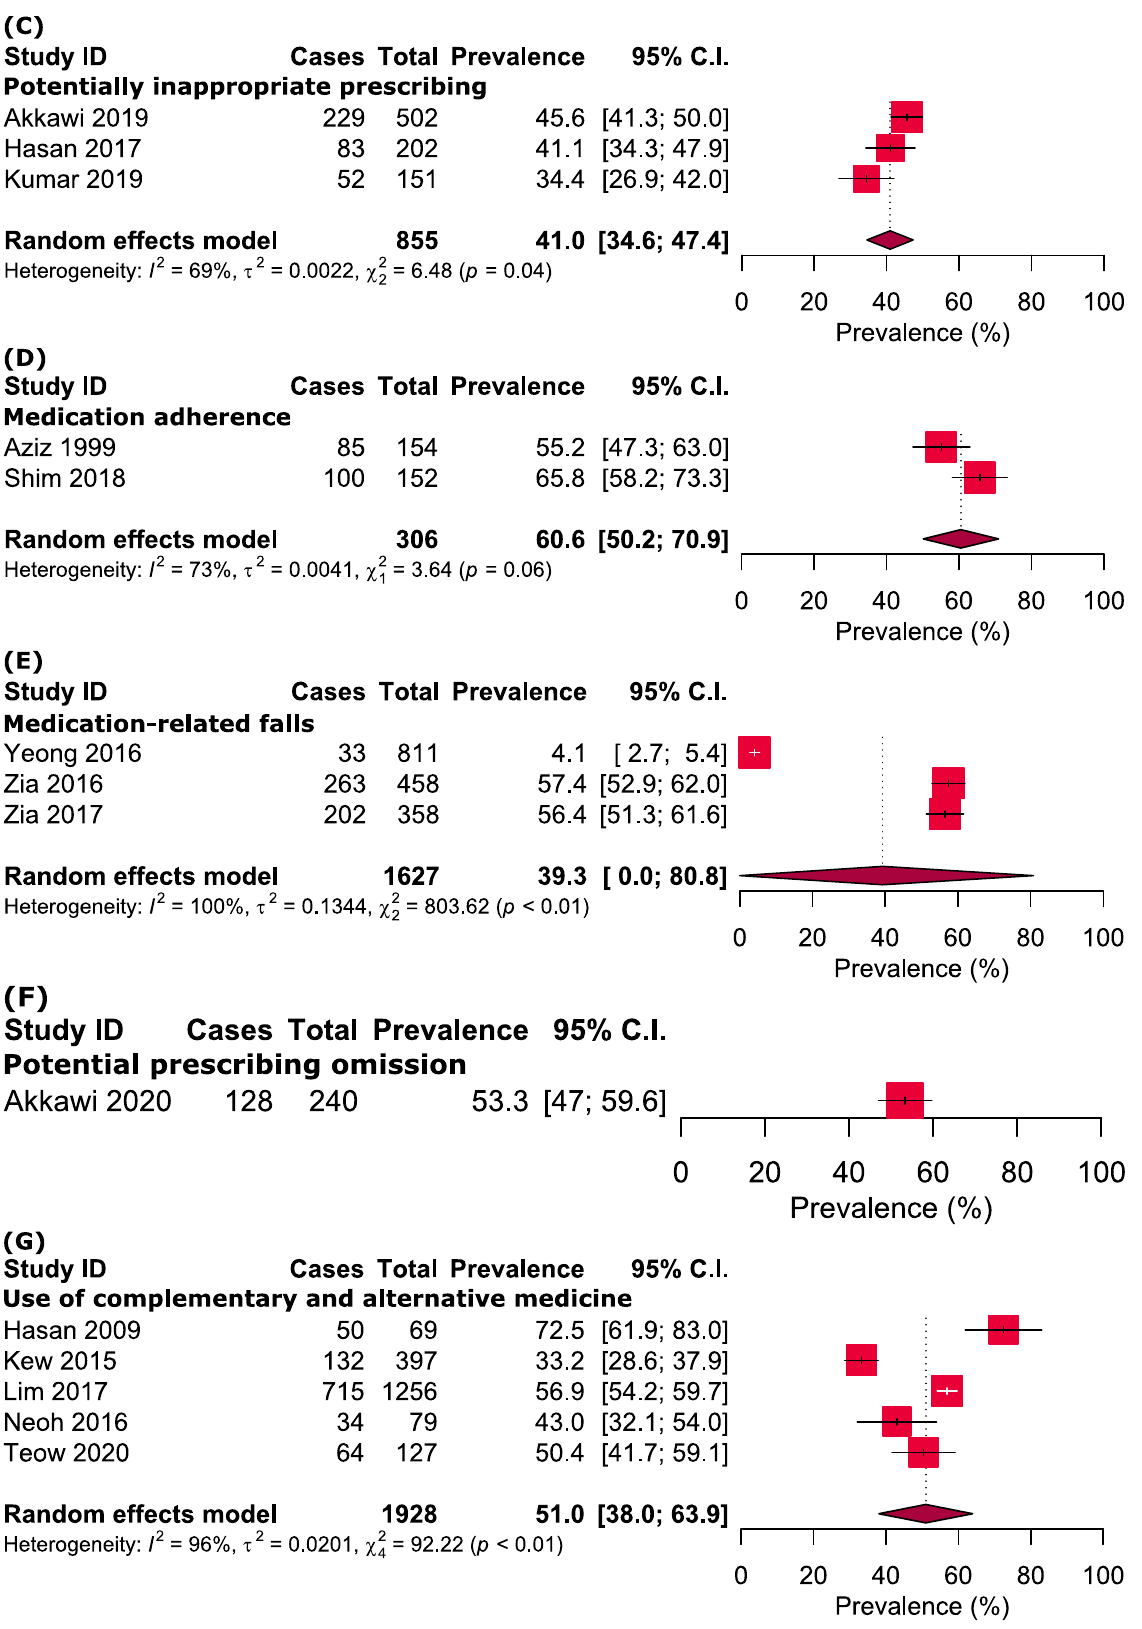
Figure 2. Prevalence of ( A ) polypharmacy, ( B ) potentially inappropriate medications, ( C ) potentially inappropriate prescrib- ing, ( D ) medical adherence, ( E ) medication-related falls, ( F ) potential prescribing omission, and ( G ) use of complementary and alternative medicines among elderly individuals in